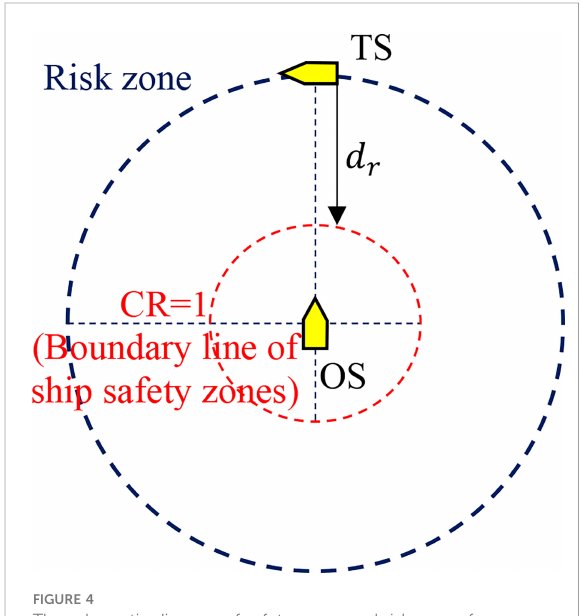
FIGURE 4 The schematic diagram of safety zones and risk zones for obstacles and own ship.